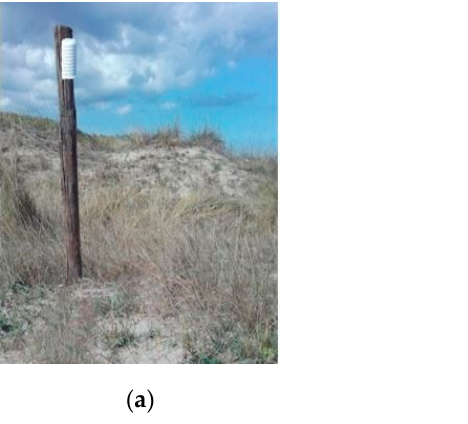
Figure 4. Air temperature sensor ( a ); sandy-soil surface temperature sensor ( b ). The pictures clearly show the presence of vegetation typical of the dune environment (Cakiletum, Ammophiletum and Agropyretum).